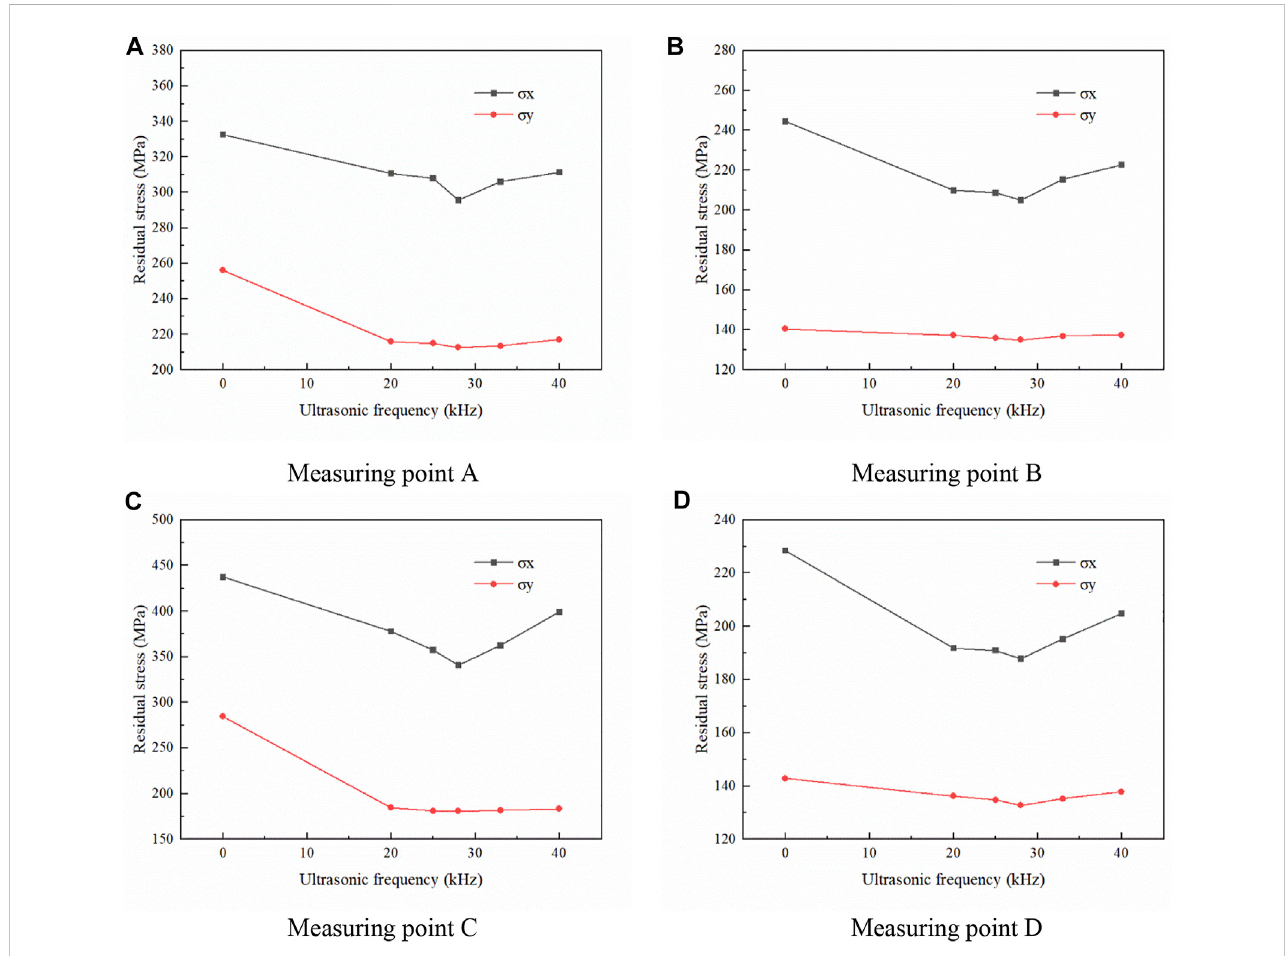
FIGURE 6 Effect of ultrasonic frequency on residual stress at each point [ (A) : Measuring point A; (B) : Measuring point B; (C) : Measuring point C; (D) : Measuring point D].